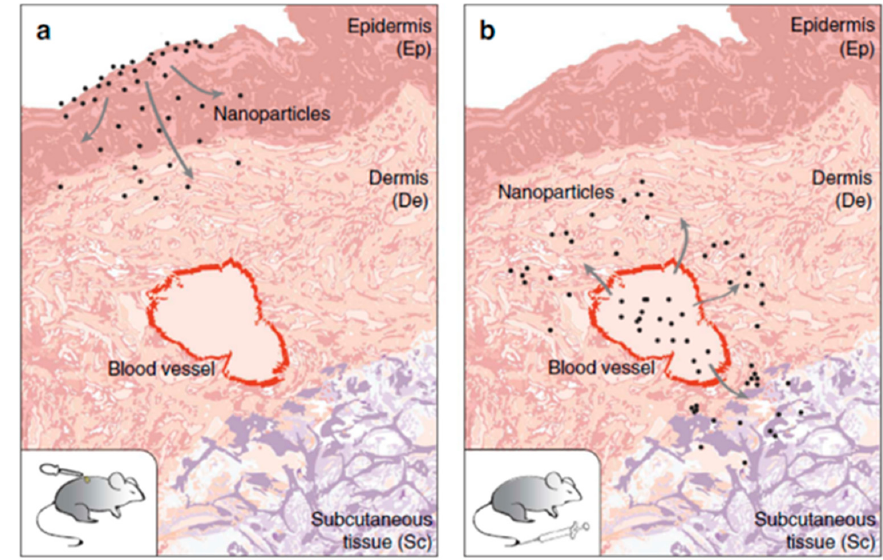
Figure 4. Route of entry of NPs in mice after topic dermal application ( a ) and tail-vein injection ( b ). When NPs were applied topically, they spread in the epidermis and dermis. The subcutaneus tissue (hypodermis) was reached by NPs only after the injection. Reprinted by permission from Macmillan Publishers Ltd. Nature Communication copyright (2014) [78].